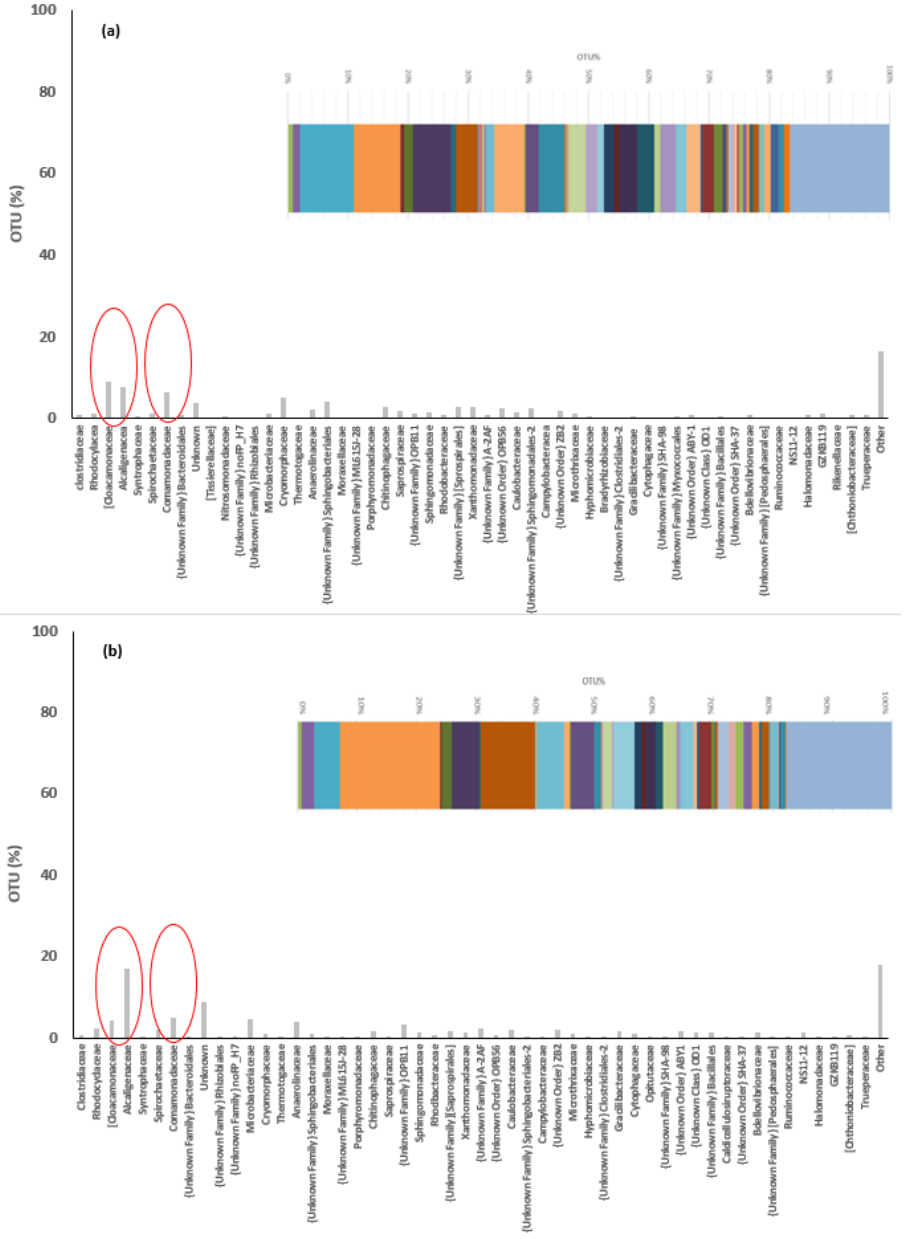
Figure 6. The operational taxonomic units (OUT) and taxonomic identities of bacterial biomass in the sequencing at the family level in MBBR R1 ( a ) and MBBR R2 ( b ) reactors.